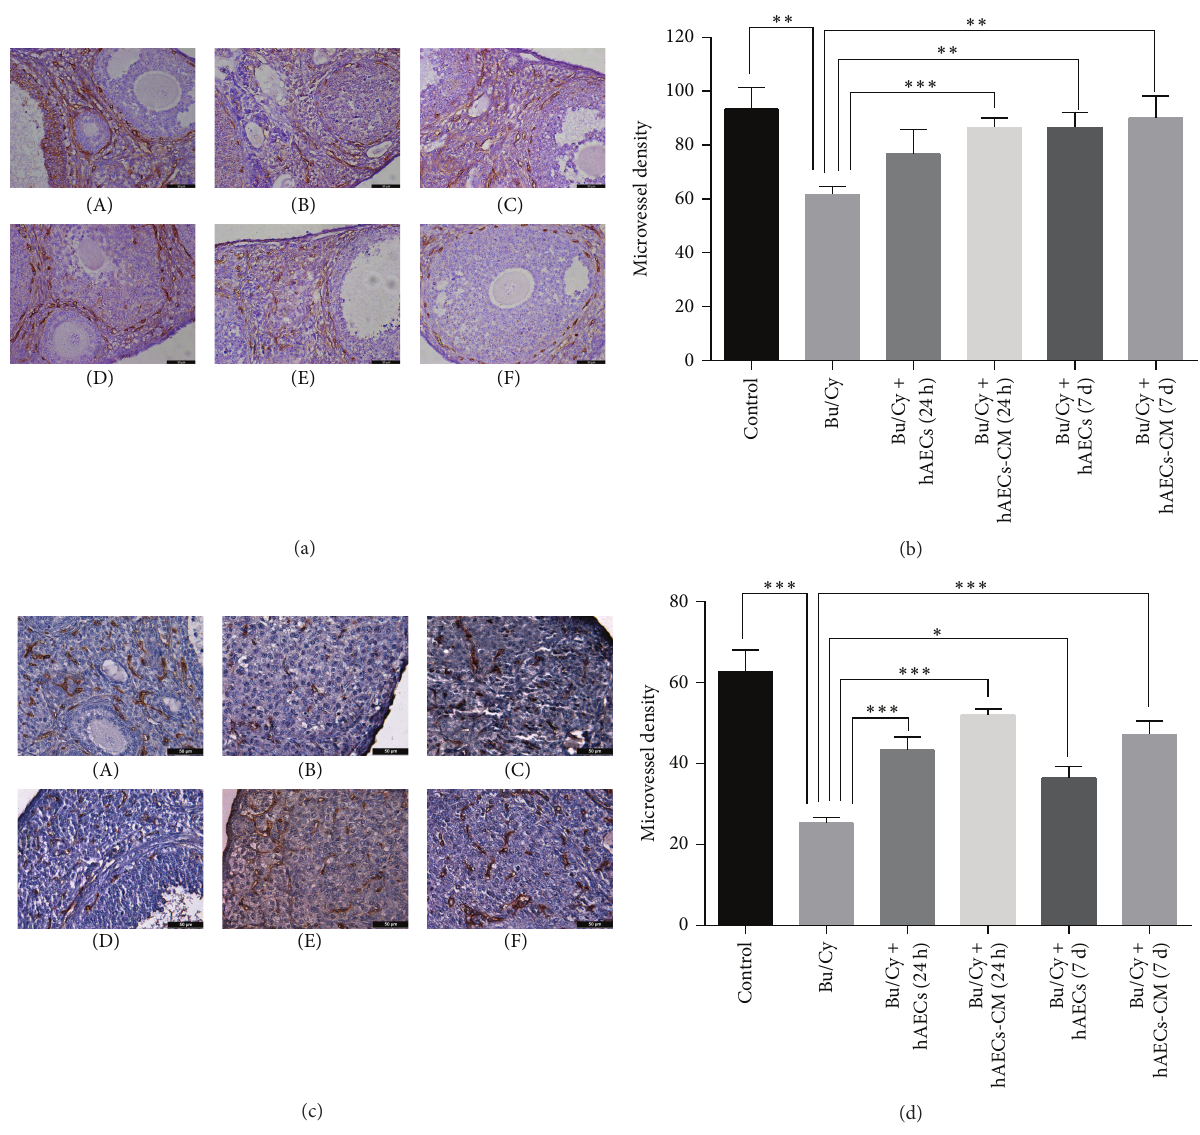
Figure 9: Angiogenesis on Bu/Cy-treated ovaries after intraperitoneal injection of hAECs or hAECs-CM. Immunohistochemistry for CD34 ((a) and (c)) and microvessel density ((b) and (d)) were examined on ovaries obtained 2 weeks ((a) and (b)) or 1 month after treatment ((c) and (d)). Data were given as mean ± SEM. (A): control group; (B): Bu/Cy administrated group; (C): Bu/Cy + hAECs (24h) group; (D): Bu/Cy + hAECs-CM (24h) group; (E): Bu/Cy + hAECs (7 d) group; (F): Bu/Cy + hAECs-CM (7 d) group. ∗ 𝑃 < 0.05 , ∗∗ 𝑃 < 0.01 , ∗∗∗ 𝑃 < 0.001 . Scale bar: 100 𝜇